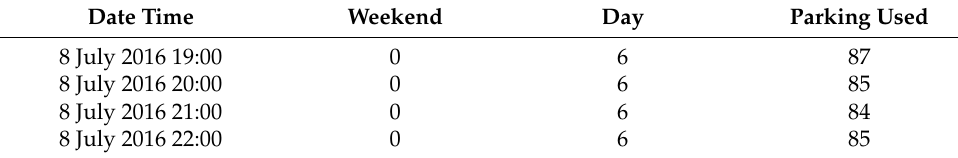
Table 2. Example data of parking used.